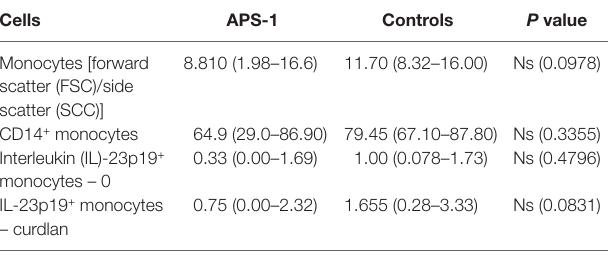
Table 3 | Monocyte counts in autoimmune polyendocrine syndrome type 1 (APS-1) and controls.